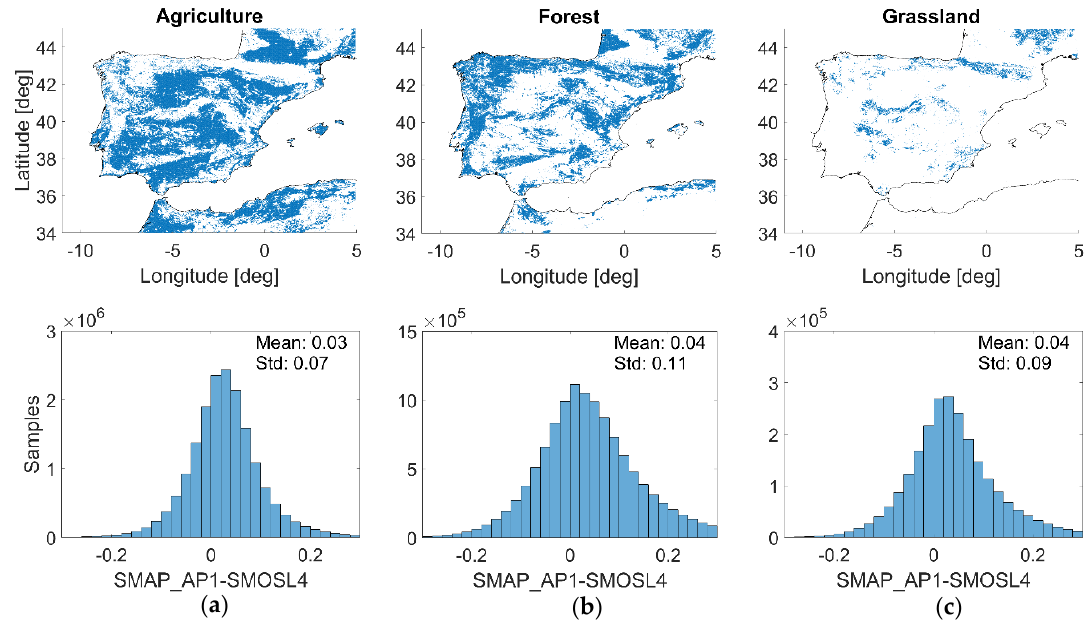
Figure 6. (First row) The three most common land covers types over the Iberian Peninsula ( a ), agriculture; ( b ) forest; and ( c ), grassland) according to the CCI LC map. (Second row) Histograms of the daily SSM differences (SMAP_AP1 minus SMOSL4) for the respective land covers.